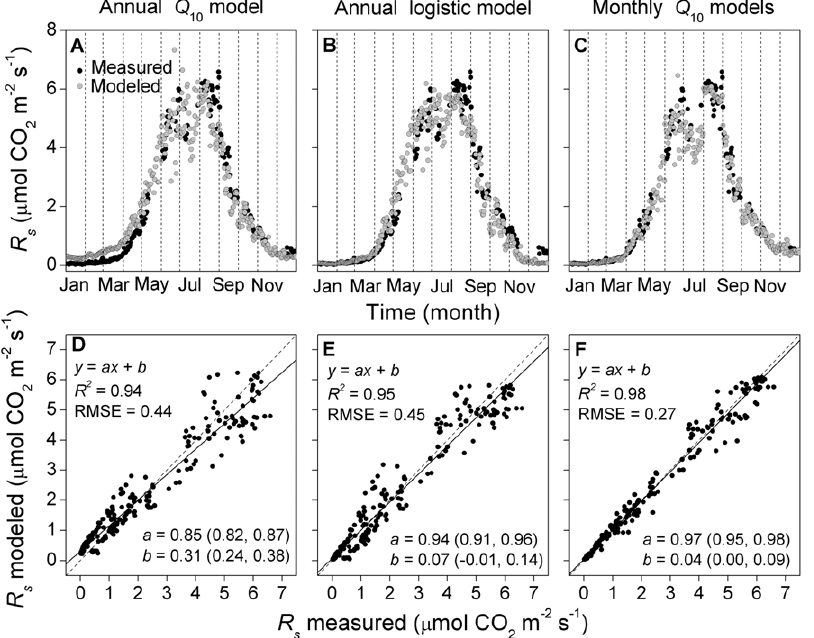
Figure 3. Comparisons between measured and modeled daily mean soil respiration ( R s ). Modeled R s values were derived from (A and D) an annual Q 10 model, (B and E) an annual logistic model, or (C and F) monthly Q 10 models. Values in parentheses in (D–F) represent 95% confidence intervals.